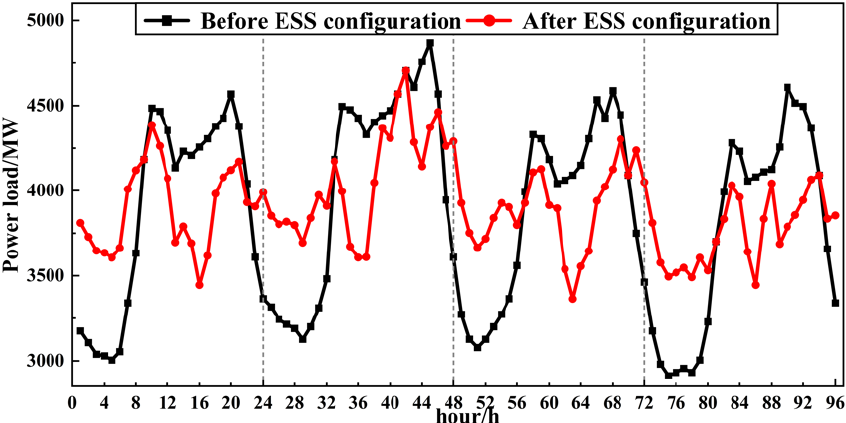
Figure 9. Total power demand before and after the EES configuration.